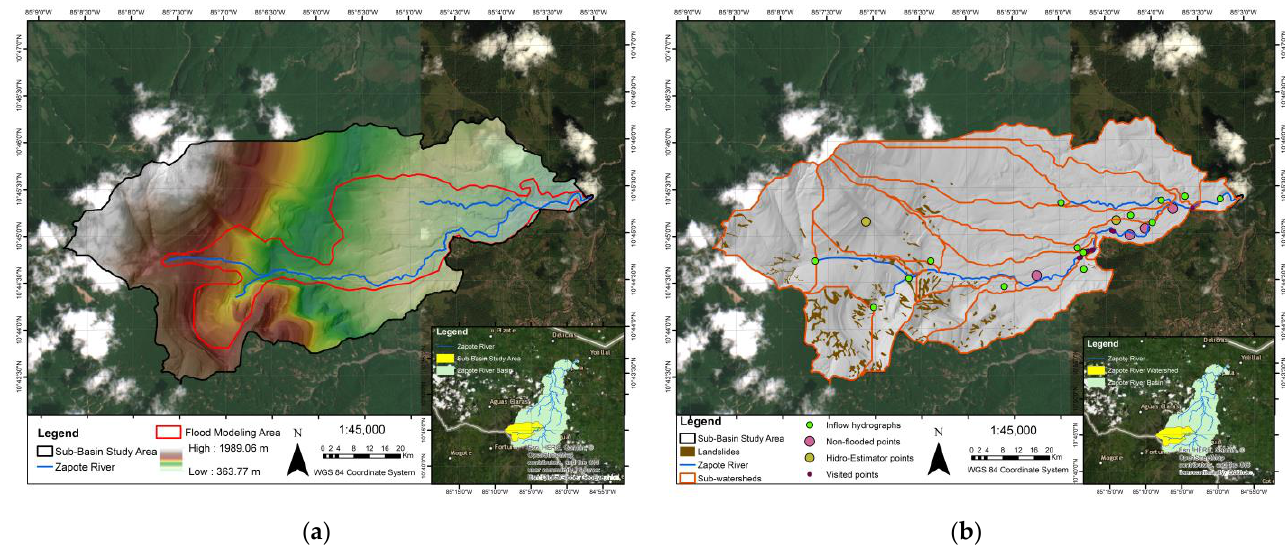
Figure 1. ( a ) Sub-basin study (black polygon) and flood modeling (red polygon) areas, topography, and river location; ( b ) sub-watersheds, landslides detected by satellite image, inflow hydrograph, and measurement points.